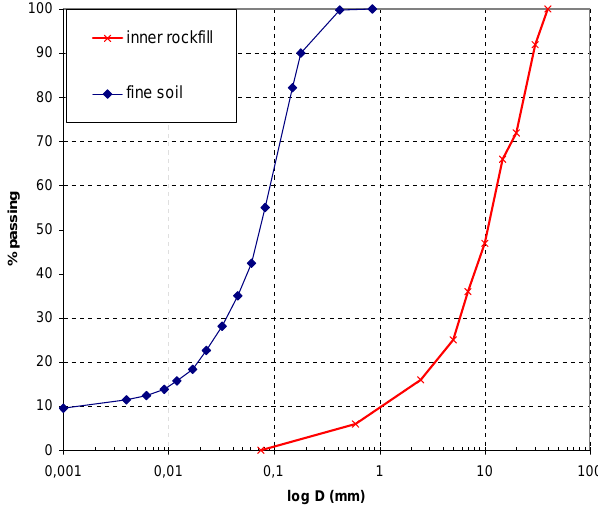
Fig. 7. Grain size distribution curves of the inner rockfill and finer Figure 7 - Grain size distribution curves of the inner rockfill and finer soil along the slopes for 6 soil along the slopes for the Acquaviva railway the Acquaviva railway embankment 7